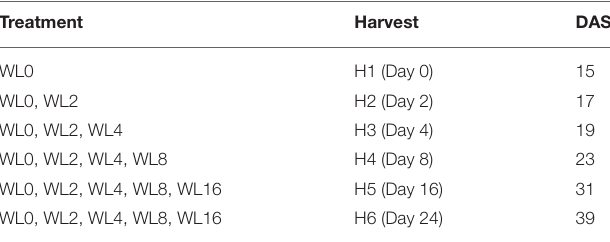
TABLE 2 | Harvesting schedule for Experiment B: Initial harvest occurred on the day waterlogging was imposed at 15 days after sowing (DAS). Treatment